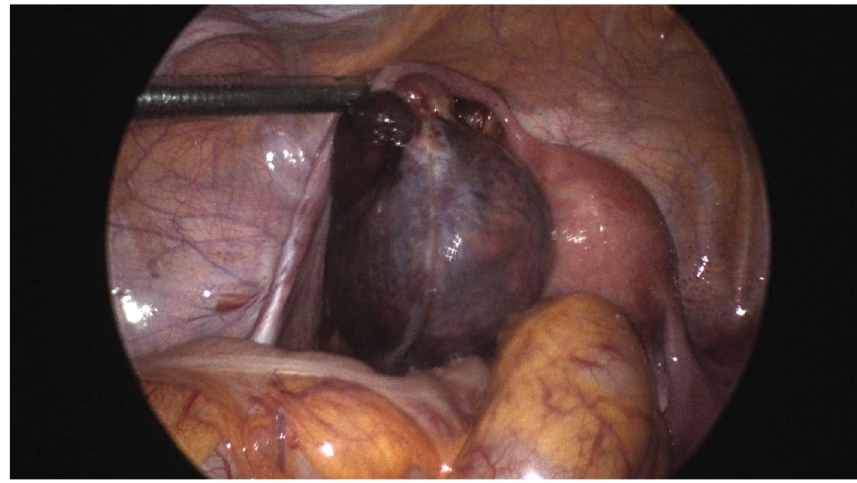
Figure 3: Dilated and gangrenous left fallopian tube.